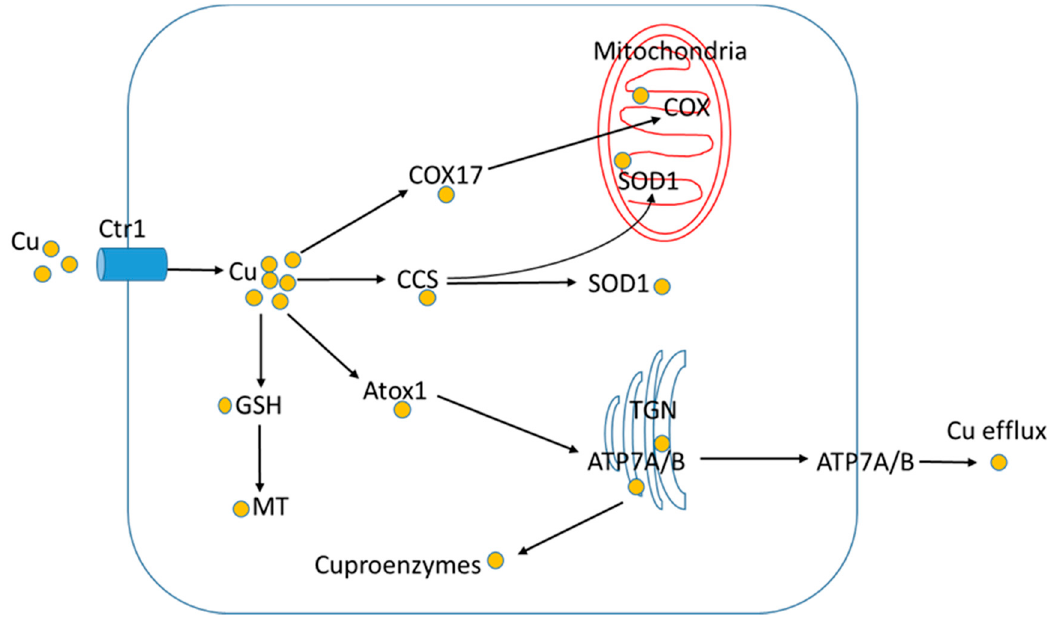
Figure 2. Cellular copper distribution. Ctr1, copper transporter 1; MT, metallothionein; GSH, glutathione; CCS, copper chaperone for SOD1; COX, cytochrome c oxidase; Atox1, antioxidant protein 1.